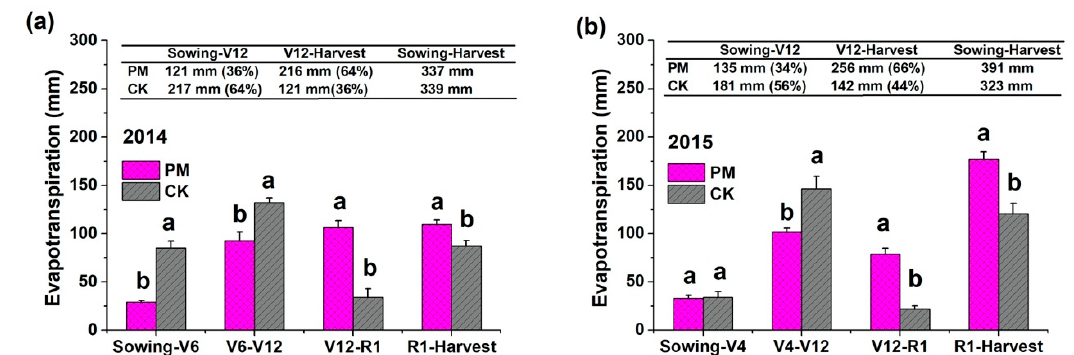
Figure 6. Evapotranspiration (ET) in the mulched (PM) and check (CK) plots in ( a ) 2014 and ( b ) 2015. Inset: The ET during di ff erent periods and their share of the total ET. V4: four-leaf stage, V6: six-leaf stage, V12: twelve-leaf stage, and R1: silking stage. The di ff erent lowercase letters indicate a significant di ff erence among the treatments at p < 0.05.